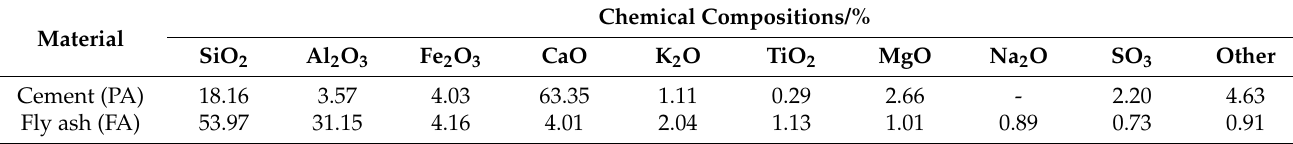
Table 2. Chemical composition of the cement and fly ash.